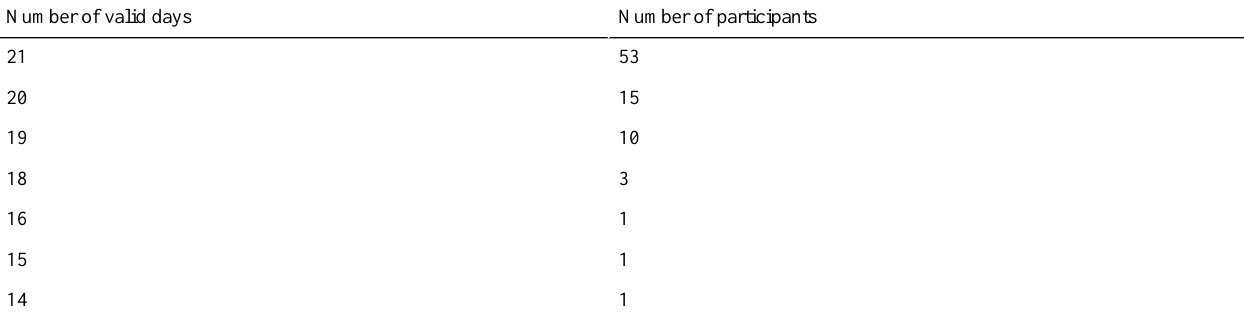
Table 1. The distribution of the number of valid days (1702 days in total) among participants